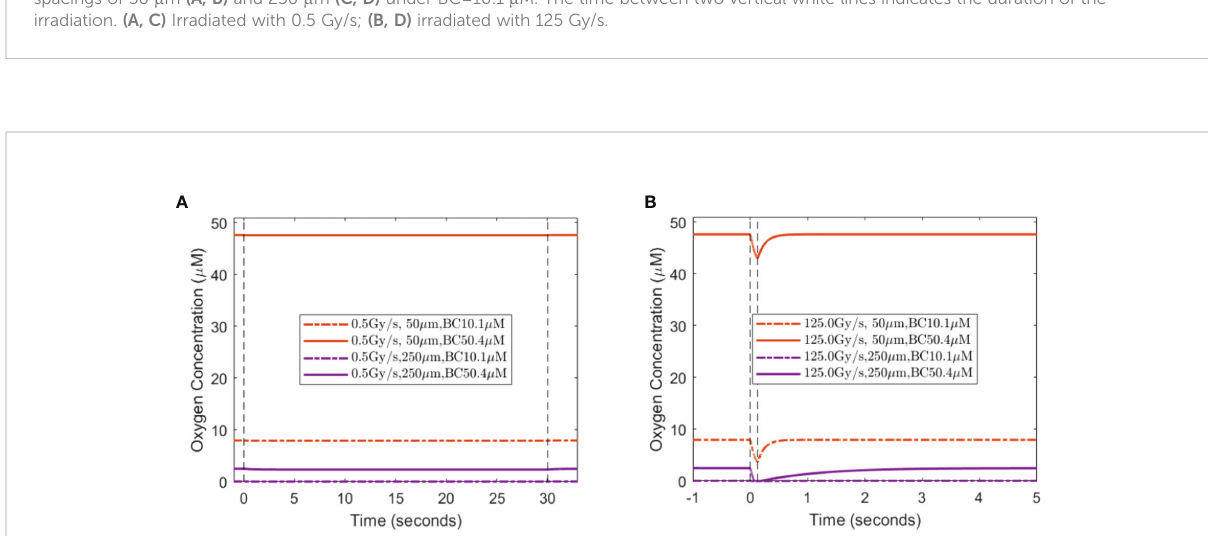
FIGURE 4 Midpoint oxygen levels for different oxygen supply BCs, vasculature spacings, and dose rates. The change in oxygen concentration from 15 Gy irradiation under the dose rates of (A) 0.5 Gy/s and (B) 125 Gy/s under 10.1 and 50.4 m M for 50 and 250 m m spacings. The dashed vertical lines indicate the duration of the irradiation.